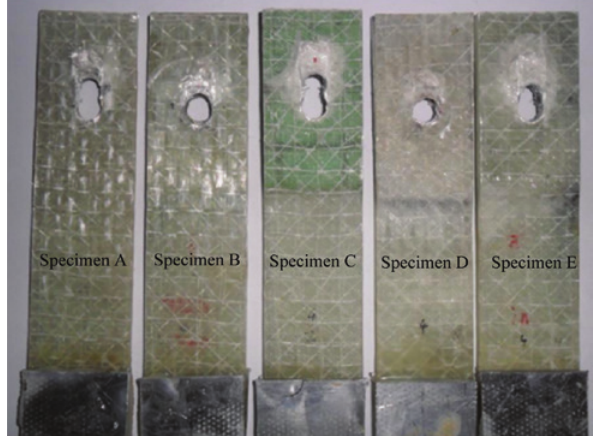
Figure 1: Photos of test specimens.